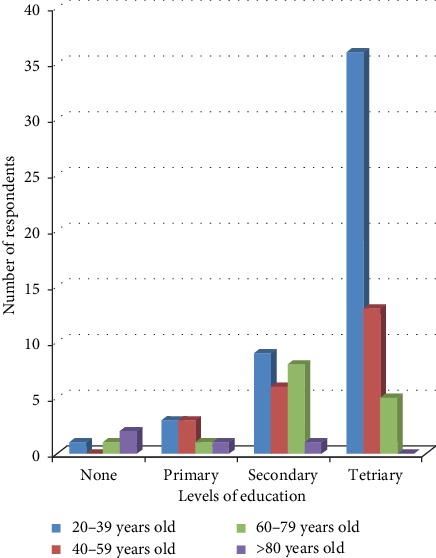
Age distribution and level of education of the respondents.